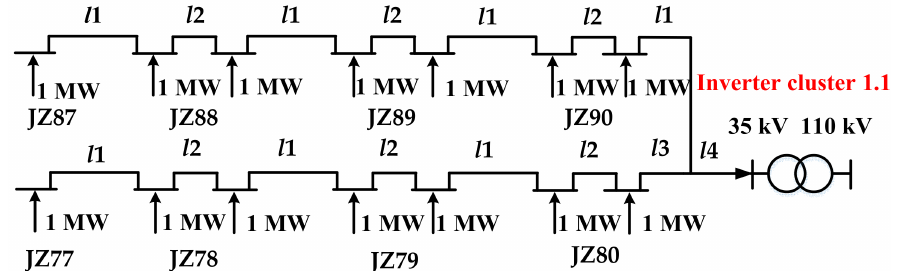
Figure 3. Structural diagram of inverter cluster